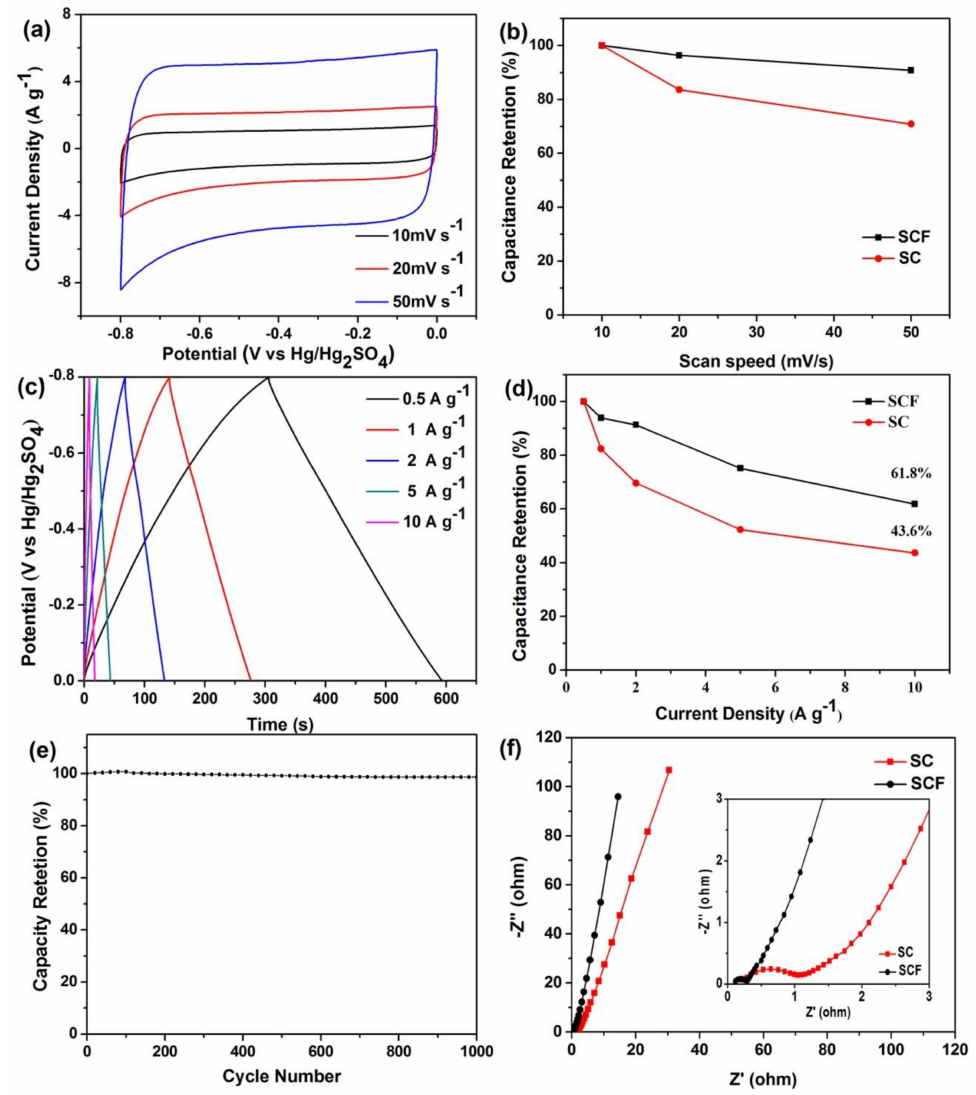
Figure 5. Electrochemical performances are measured in a three-electrodesystem using 5 M H 2 SO 4 astheelectrolyte. ( a ) Cyclic voltammogram CV curves of SCF at different scanning rates; ( b ) Capacitance retentions of SCF and SC at different scanning speeds; ( c ) Galvanostatic charge-discharge GCD curves of SCF at different current densities; ( d ) Capacitance retentions of SCF and SC at different currents densities; ( e ) Cycling stability of SCF at 0.5 A · g − 1 ; ( f ) Nyquist plots of SCF and SC electrodes in the frequency range of 0.01 Hz–100 kHz with the inset showing the high and middle frequency